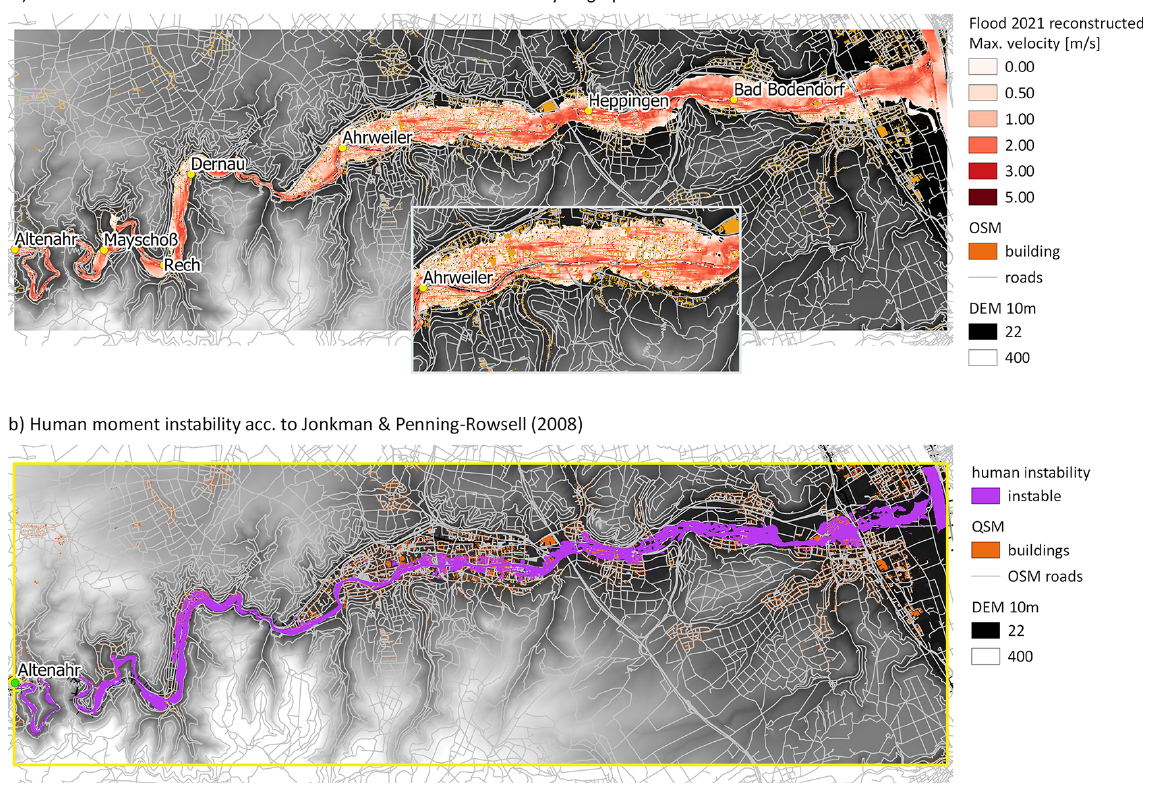
Figure 3. Flow velocities and human instability indicator for the flood event in July 2021 using the reconstructed hydrograph: (a) sim- ulated maximum effective flow velocities; (b) areas indicating human moment instability in flowing water derived from the maximum values of the product of water depth and flow velocity. The critical value for human instability was set to 1m 2 s − 1 , following Jonkman and Penning-Rowsell (2008) and considering potential underestimation of flow velocities by RIM2D. Data sources: DEM 10m resolution: © GeoBasis-DE/BKG 2012 (https://www.bkg.bund.de/, last access: 30 January 2022); OSM river network and buildings: © OpenStreetMap contributors 2021. Distributed under the Open Data Commons Open Database License (ODbL)